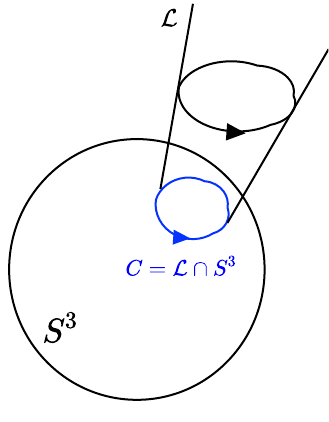
Figure 12 . The generating functional for Wilson loops can be viewed as the open string amplitude on the deformed conifold with dynamical branes wrapping S 3 and probe branes wrapping L . They intersect along a knot C on S 3 ,colored in